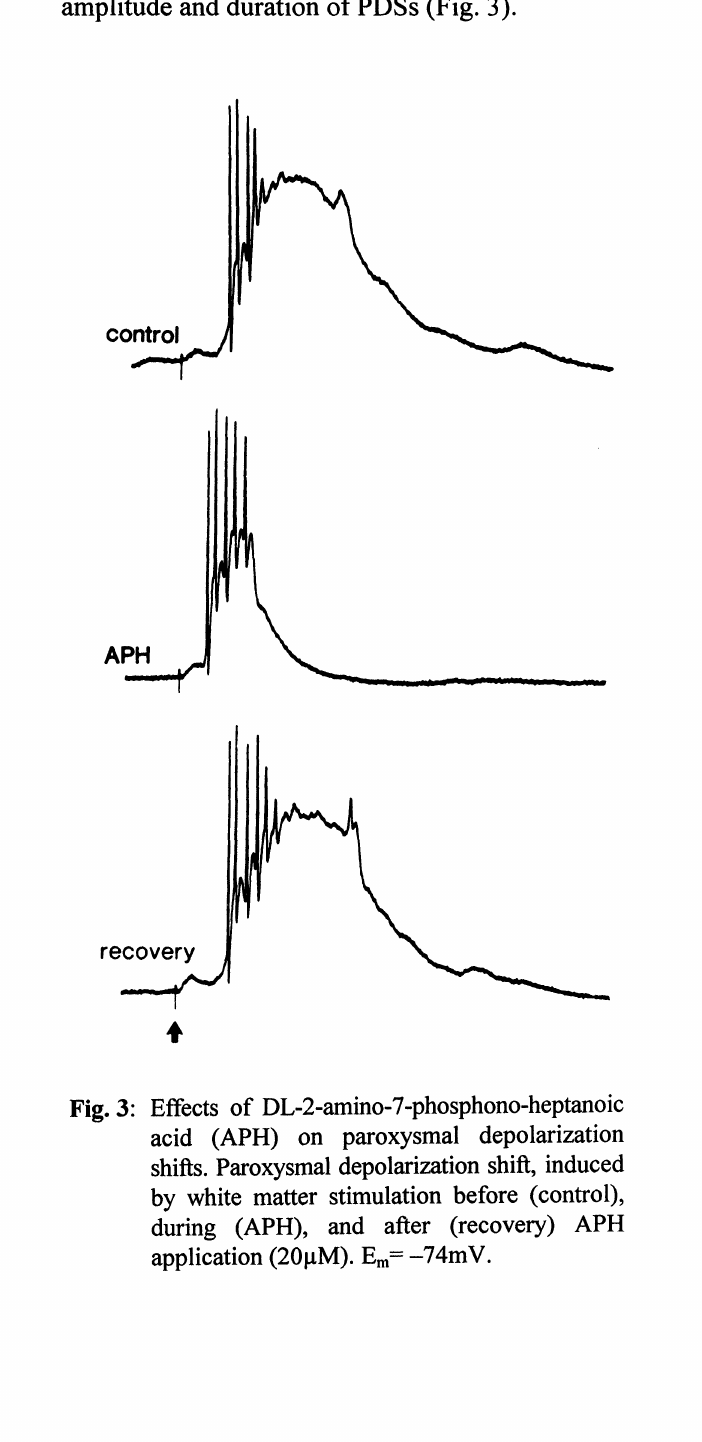
Fig. 3: Effects of DL-2-amino-7-phosphono-heptanoic acid (APH) on paroxysmal depolarization shifts. Paroxysmal depolarization shift, induced by white matter stimulation before (control), during (APH), and after (recovery) APH application (20tM). Em